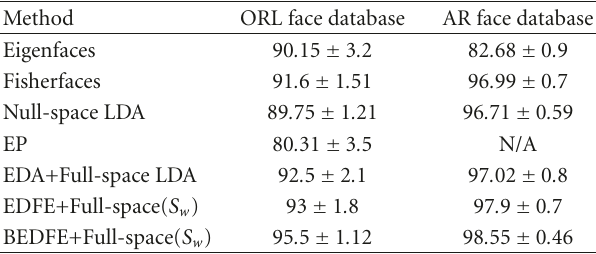
Table 4: The mean and standard deviation of recognition accuracy (%) of the proposed EDFE and BEDFE methods and some other state-of-the-art methods on the ORL and AR face